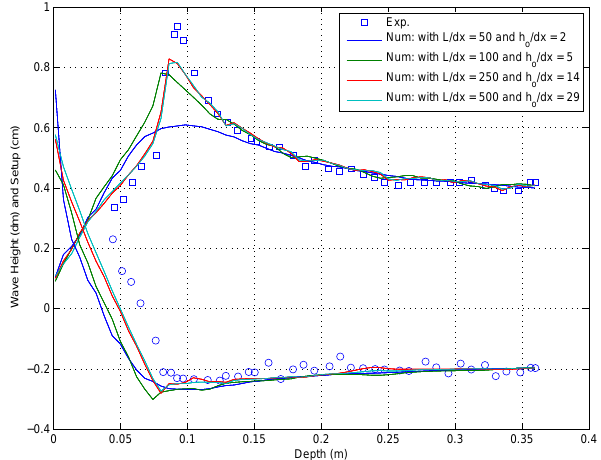
Fig. A2. Computed and measured wave heights and setup for the Hansen and Svendsen case 041041 ( kh o = 0 . 501, H/h o = 0 .